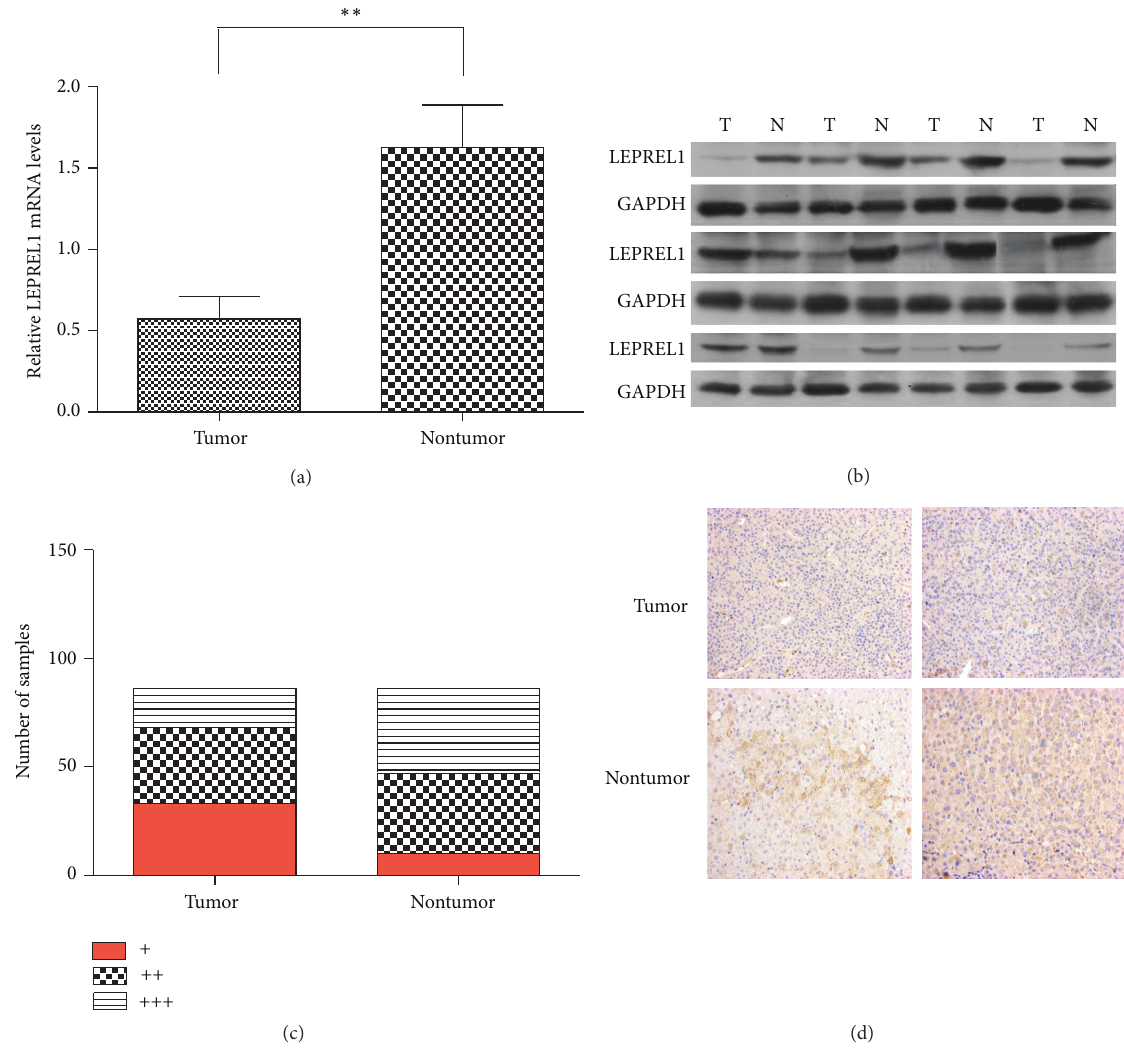
Figure 1: LEPREL1 was frequently downregulated in HCC. (a) The expression level of LEPREL1 relative to GAPDH was compared between the nontumorous and tumor tissues in 80 HCCs using quantitative RT-PCR. Expression of LEPREL1 in tumor tissues was significantly lower than that of the nontumorous tissues ( 𝑃 < 0.001 , 𝑛 = 80 ). (b) Representative pictures of LEPREL1 protein expression in randomly selected paired HCC nontumor and tumor tissues. GAPDH was used as an endogenous control. LEPREL1 was downregulated in most of the tumor tissues as compared to the adjacent nontumorous tissues. ((c), (d)) Expression of LEPREL1 in the tumor tissues and adjacent nontumor tissues. Representative pictures of the immunohistochemistry results of LEPREL1 in tissues (d) and histogram of semiquantitatively with a three-tiered system grades ( 𝑛 = 86 ). N: nontumor, T: